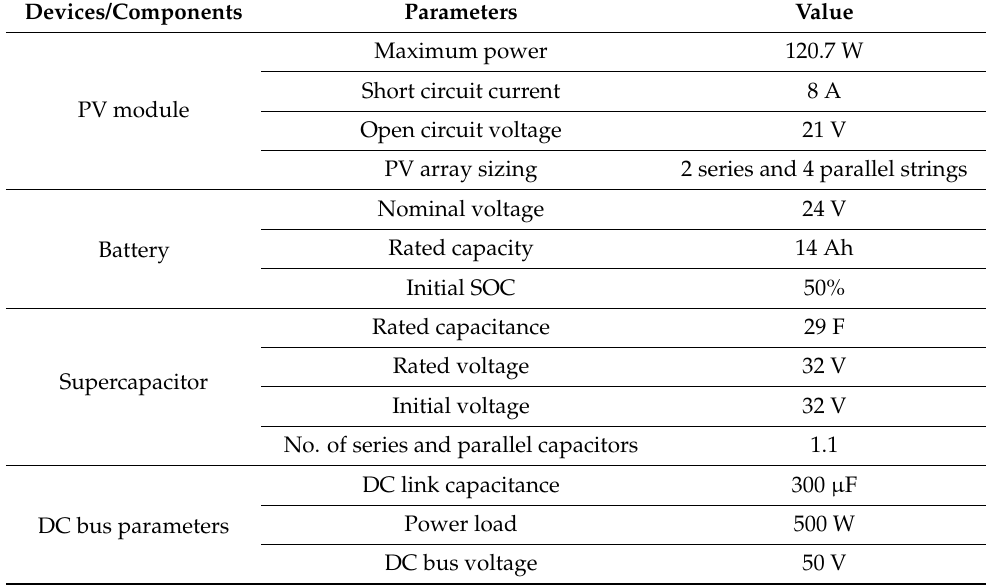
Table 2. The system parameter specifications